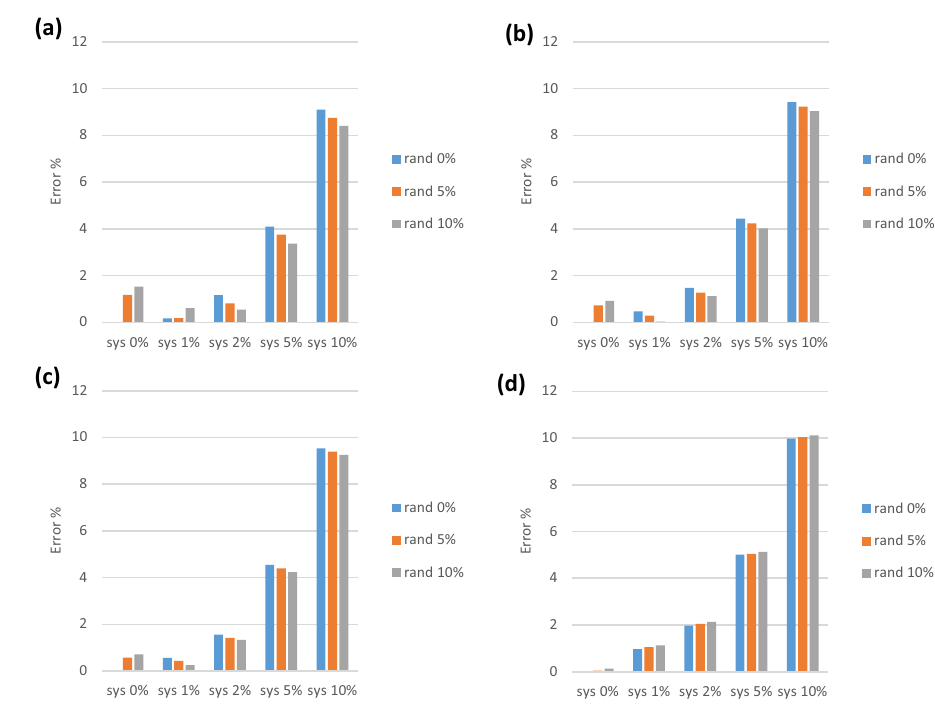
Fig. 5 Final errors of the history matching in estimating: a oil production; b gas production; c porosity; and d permeability for all the employed data sets for the oil reservoir (“sys” and “rand” refer to systematic and random errors, respectively). Systematic error has had a con- siderable effect on the history